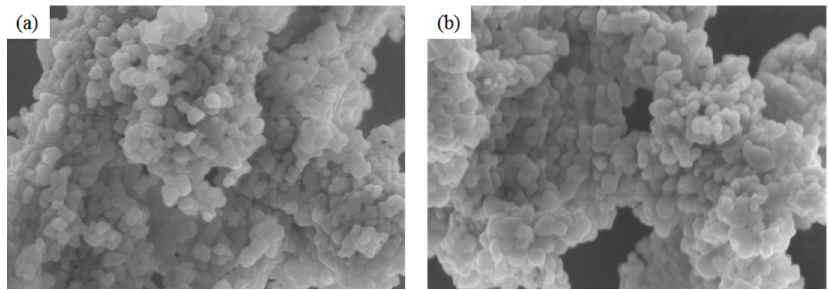
Figure 1. SEM images of ( a ) pure and ( b ) 5 mol % Ag-modified In 2 O 3 nanomaterials.